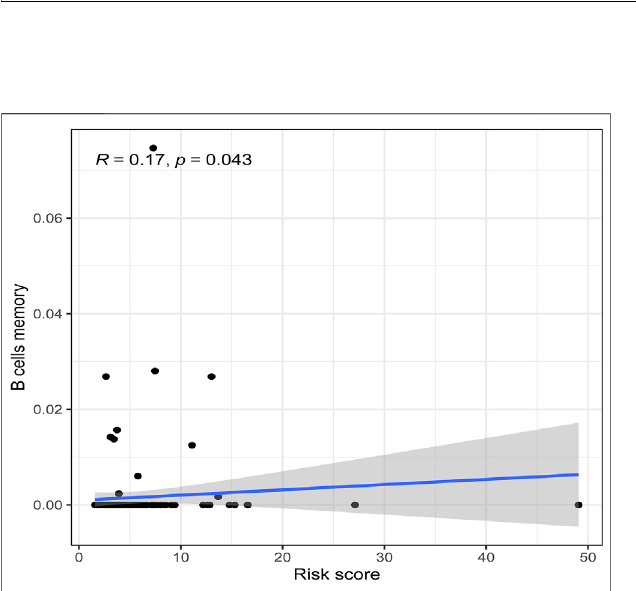
FIGURE 11 | Different expressions of ESTIMATEscore, Immunescore, and Stromalscore in two clusters ( p < 0.05).